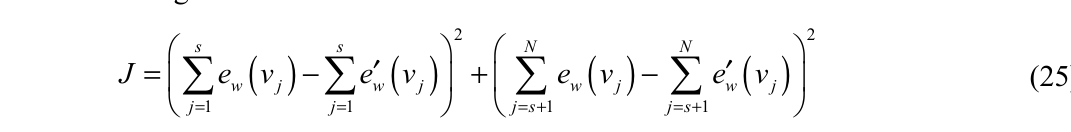
Figure 6. Evolution of the mean and standard deviation of the relative error error different selected wind speeds v